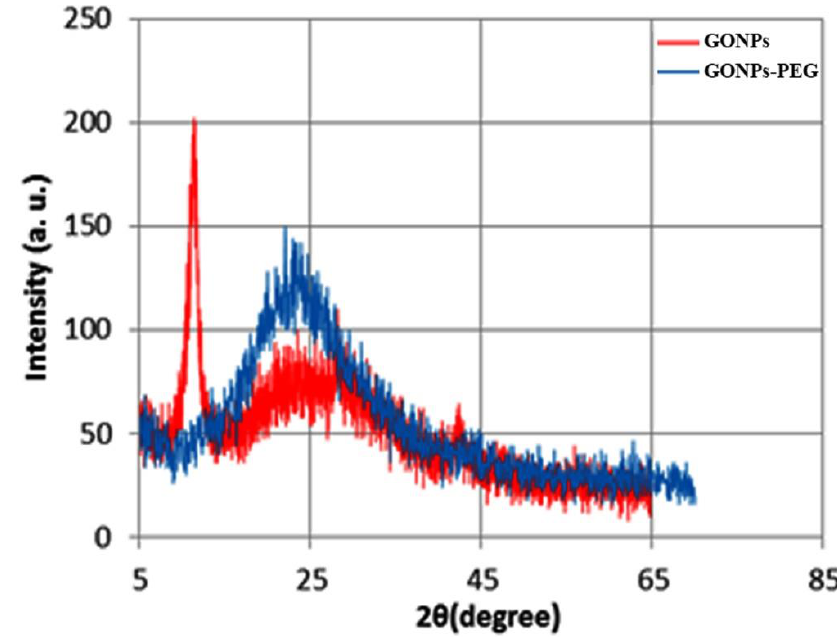
Figure 1. XRD patterns of GONPs and GONPs–PEG.